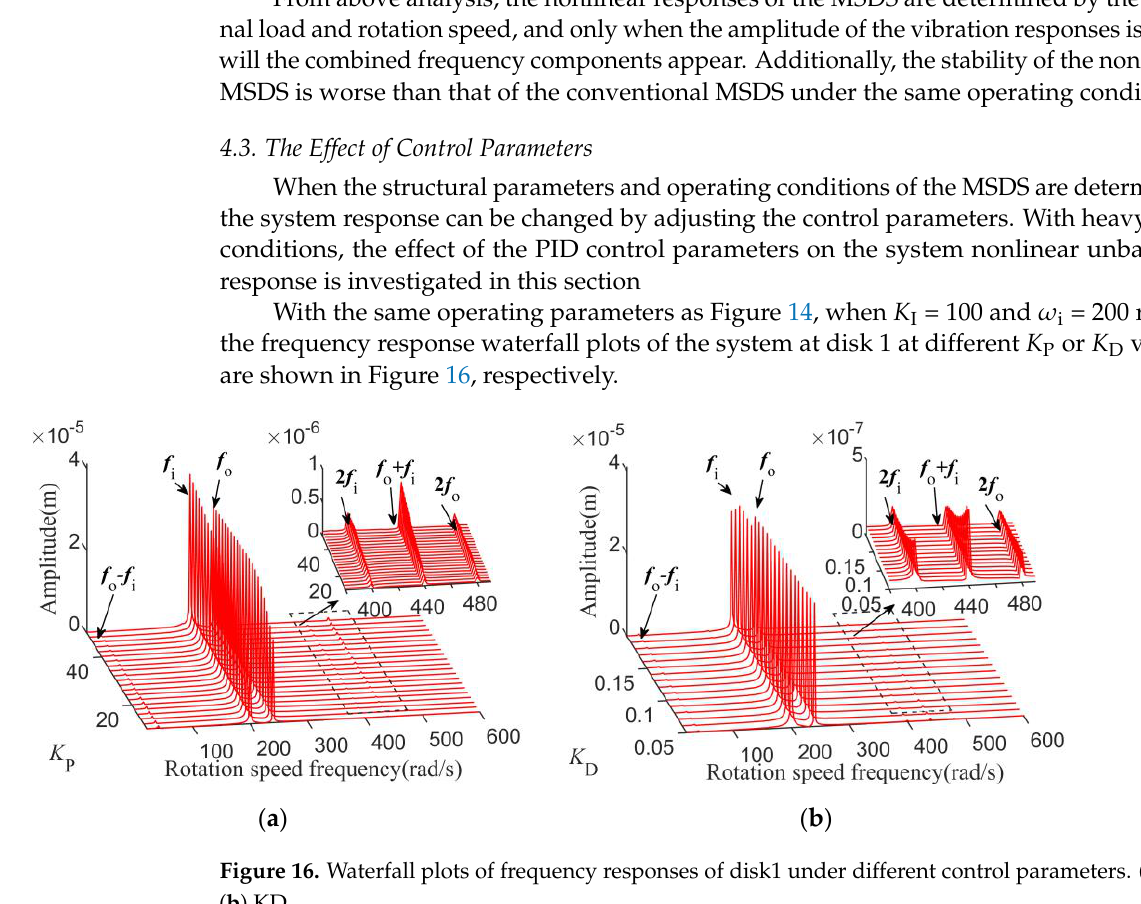
Figure 15. The stable operation area of the two systems under load conditions. ( a ) The conventional MSDS. ( b ) The nonlinear MSDS.